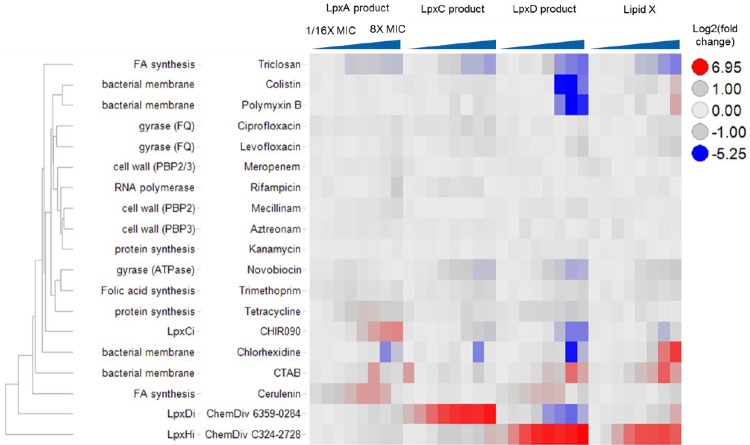
Heatmap displaying LPS intermediate levels of E. coli Δcdh ΔtolC cells treated with various antibiotics in dose-response.The red color indicates an accumulation, grey indicates no significant change, and blue indicates depletion. Hierarchical clustering was performed in Spotfire (version 6.5.3) and displayed as a row dendogram. Values in all columns were normalized to scale between 0 and 1 and used in the clustering calculation. Distances between all possible combinations of two rows were calculated using Euclidean distance measure. These calculated distances were then used in the UPGMA clustering method to derive the distance between all clusters that were formed from the rows during the clustering.